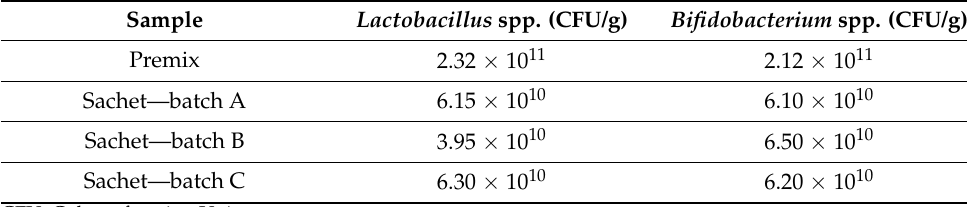
Table 3. Results obtained from plate count method of food supplement 1.